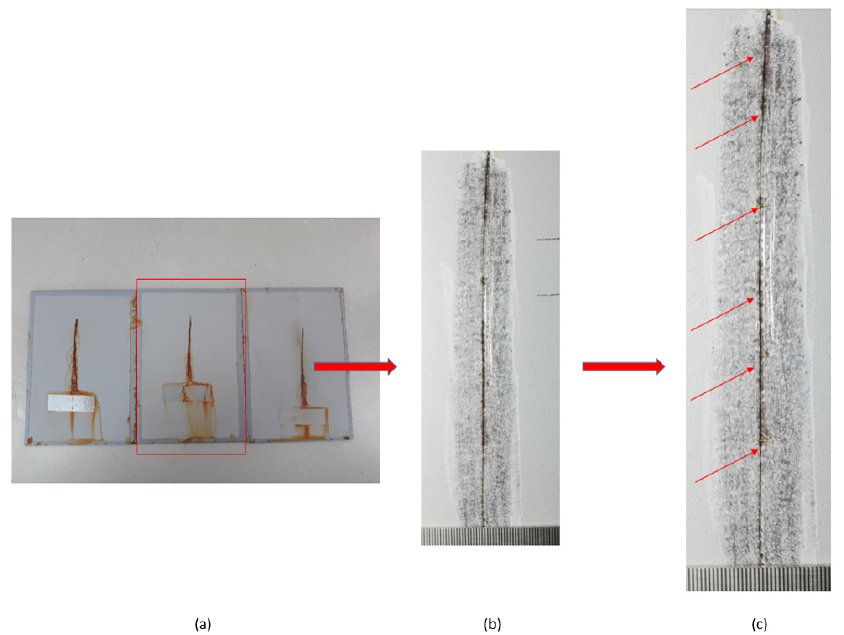
Figure 7. Notch corrosion test procedure: ( a ) the test sample after removal from the salt chamber; ( b ) removal of the coating around the notch; and ( c ) detection of places where the development of corrosion mechanisms occurred.